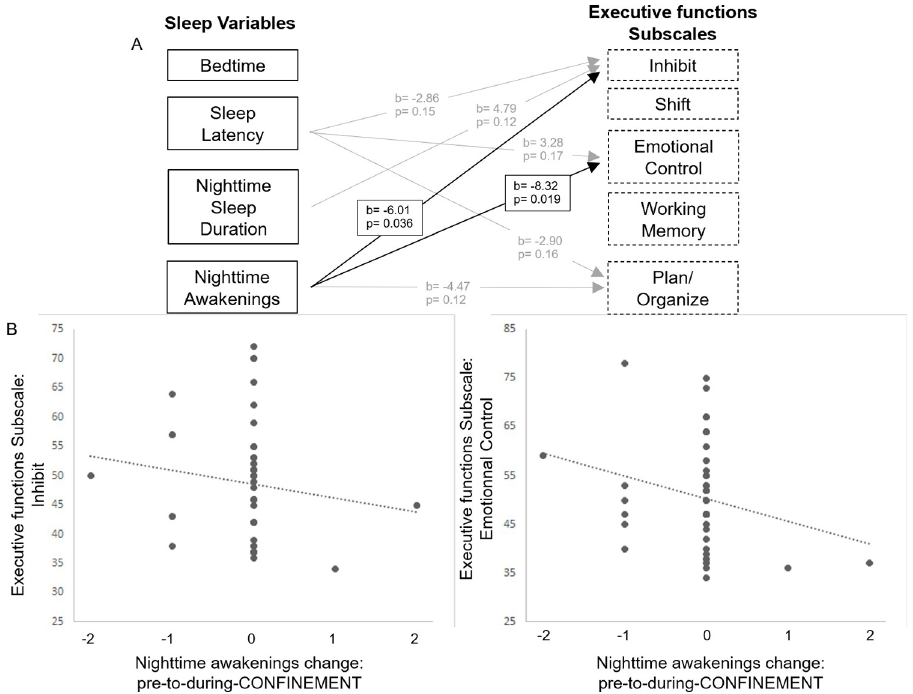
Fig 6. Prediction of executive function subscales by confinement-induced sleep behavior changes in young children. (A)The change in sleep is computed from subtraction pre-to-during-CONFINEMENT in each sleep behavior. Missing values indicate that sleep behavior did not survive the statistical backward selection, b indicates unstandardized beta coefficients, p represents corrected p-values from the linear mixed model. (B) Evolution of the change pre-to-during-CONFINEMENT of Nighttime awakenings and his association with the Inhibit and Emotional Control Subscale. Dashed line automatically fitted with Excel software.